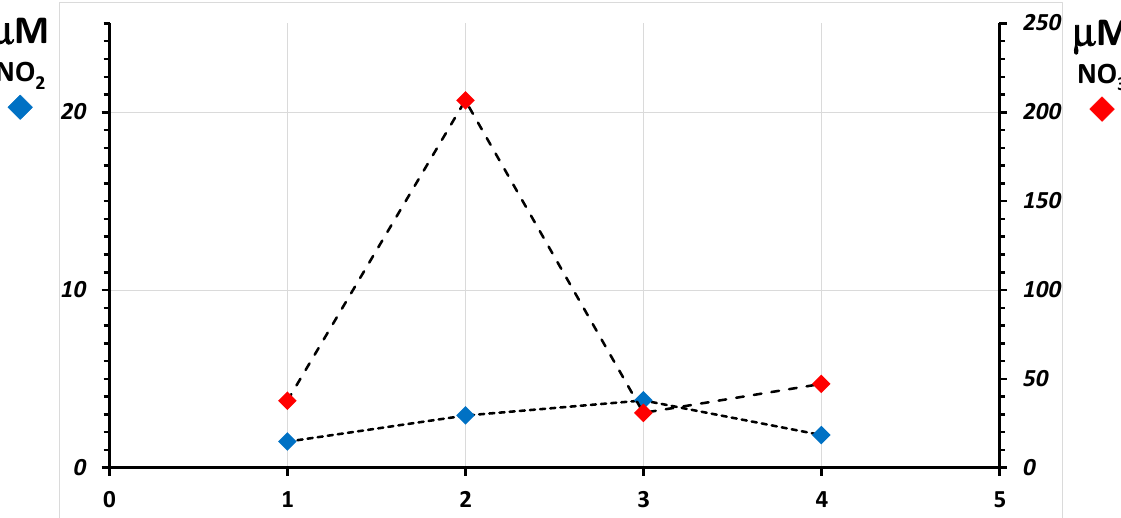
Figure 4. Line plot of the concentration of nitrite (blue diamonds) and nitrate (red diamonds) in plasma measured in one scuba diver before, during, and after training in a land-based deep-water facility. Blood samples were obtained from the subject before the exercise ( 1 ), at − 20 m depth, 10 min after the beginning of the dive ( 2 ), 15 min after surfacing ( 3 ), and 45 min after surfacing ( 4 ). The plot shows, for each measurement, the associated combined uncertainty calculated from those of nitrate and of total nitrogen oxides in the same sample.